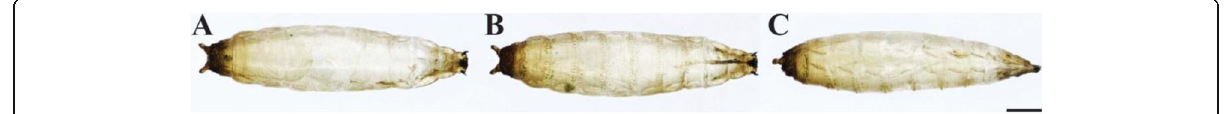
Fig. 2 Phthitia empirica puparium. Dorsal ( a ), ventral ( b ), and lateral ( c ) view (scale bar 500 μ